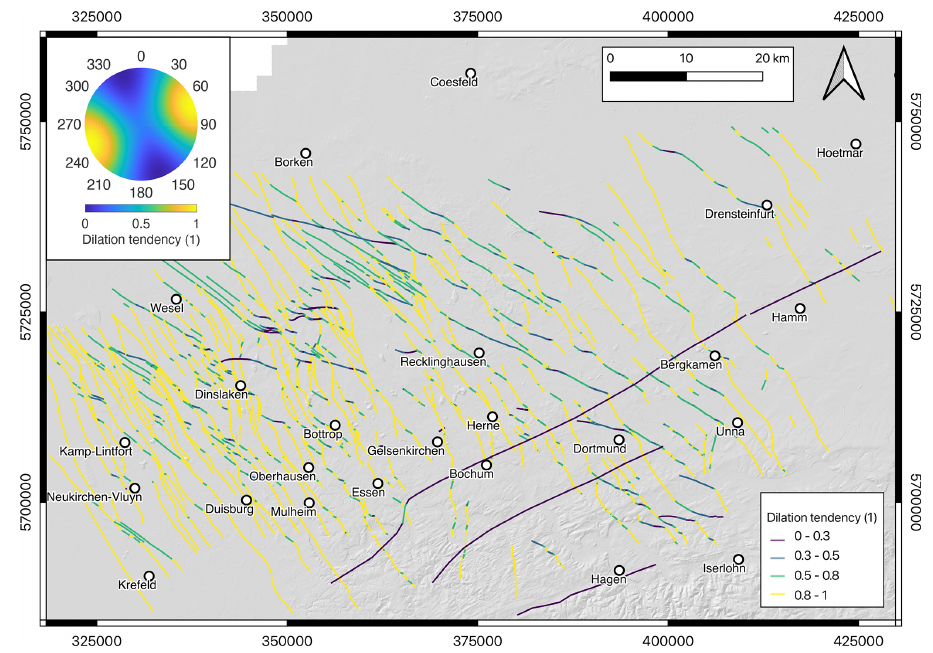
Figure 10. Dilation tendency of geological discontinuities within the Ruhr region (GD NRW, 2017, 2019) at depth of 1200m computed based on the stress tensor constrained from this study with P p of 11.8MPa, S hmin of 17.4MPa, S Hmax of 33.7MPa, S v of 29.3MPa, and average S Hmax orientation of 161 ◦ . Stereographic projection of dilation tendency based on the constructed stress tensor is presented in the top left